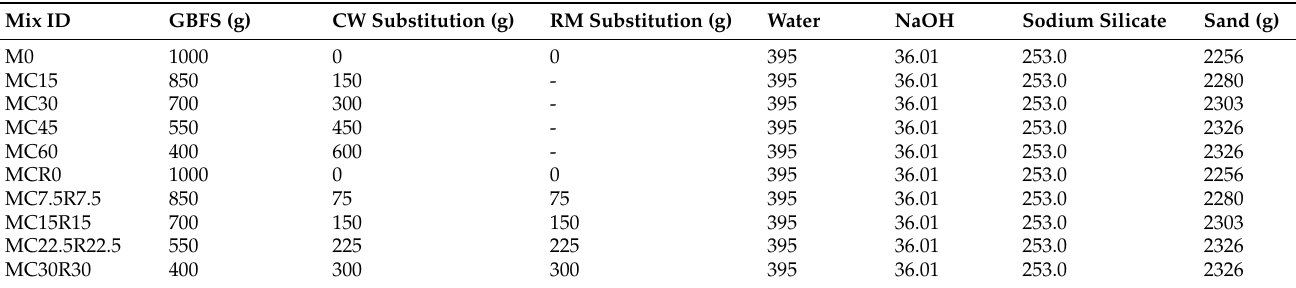
Table 2. Mix the proportion of samples (g/cm 3